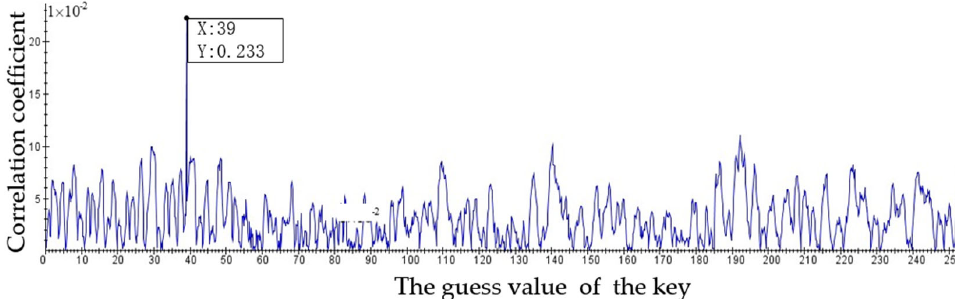
Figure 4. The first byte of 1 V CPA attack result.